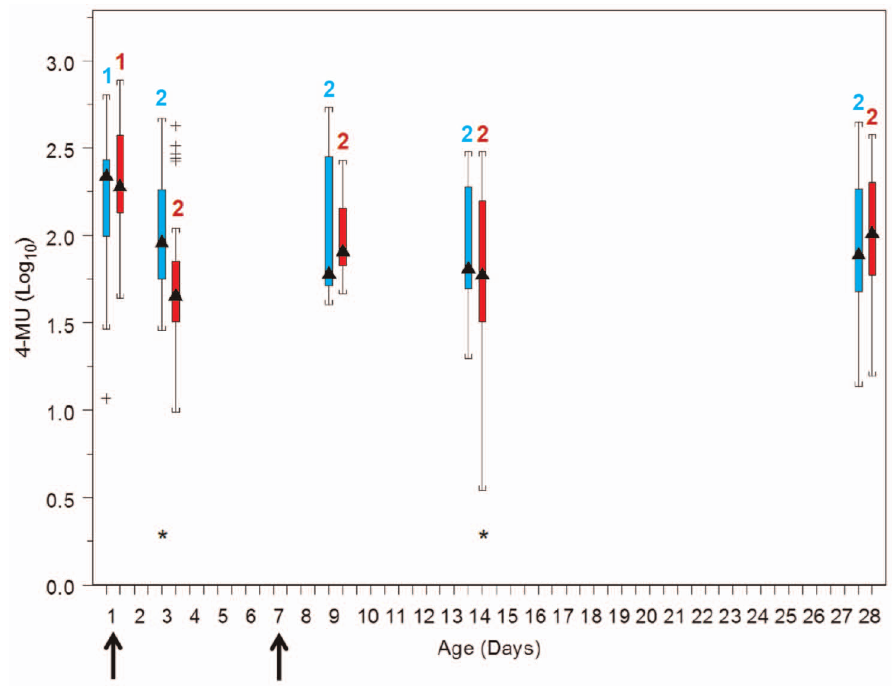
Figure 2. Boxplots of values of liberated 4-methylumbelliferone (4-MU) measured fluorometrically by age and treatment group: blue boxes are data from the control (saline) group and red boxes are data from the CpG-treated foal (see Figure 1 for boxplot description). Numbers above boxes represent within-treatment group differences among ages: within treatment group, ages with different numbers differed significantly (P , 0.05) between groups. Asterisks denote days on which values were significantly (P , 0.05) different between the control and Cp-G-treated foals. Arrows along the horizontal axis indicate ages when treatment (saline or CpG was administered.